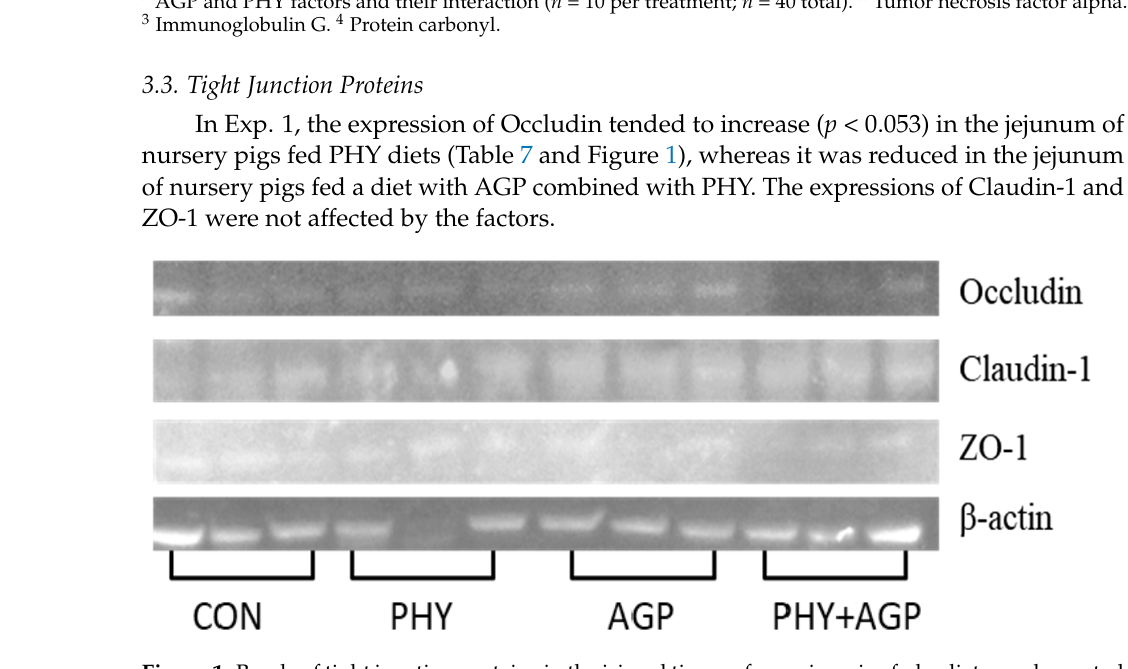
Figure 1. Bands of tight junction proteins in the jejunal tissue of weaning pigs fed a diet supplemented with phytobiotics and antibiotics as growth promoters (Exp. 1). AGP and PHY factors and their interaction ( n = 3 per treatment; n = 12 total).